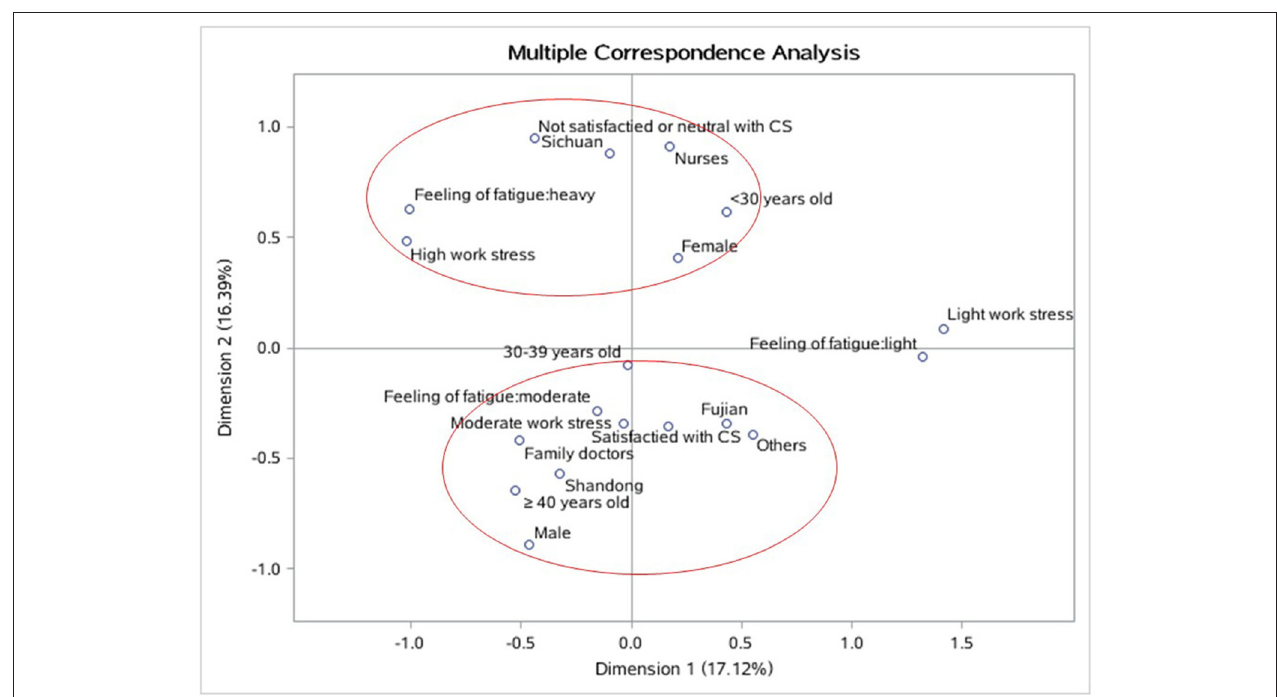
FIGURE 3 | The multiple correspondence analysis (MCA) among satisfaction with CS and its associated factors. Red rings circle the factors that cluster with different levels of satisfaction with CS. The lowest distance was considered as highest degree of similarity in the corresponding dimension. CS, contracted